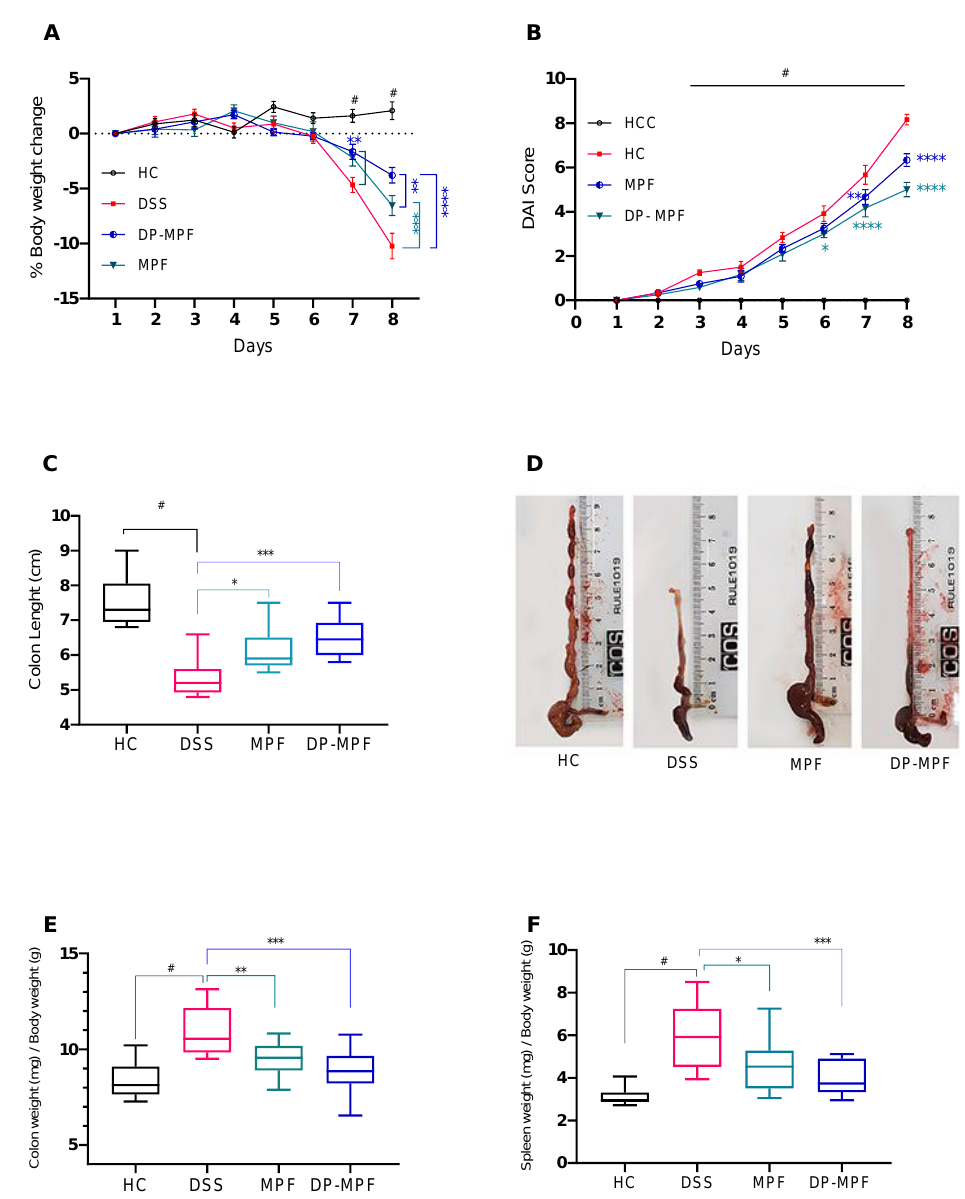
Figure 2. Effect of MPF and DP-MPF on the pathology of dextran sodium sulphate (DSS)-induced acute colitis. ( A ) % body weight change, ( B ) disease activity index (DAI) of healthy controls (HC), DSS, MPF and DP-MPF treated groups. Statistical significance was evaluated using two-way ANOVA followed by Tukey’s post-test. # Significant effect HC vs. DSS ( p < 0.05); * Significant effect treatment vs. DSS (DSS vs. MPF) or (DSS vs. DP-MPF). A p -value of <0.05 was considered significant. * p < 0.05, ** p < 0.001, *** p < 0.0001 and **** p < 0.00001. Data expressed as a mean ± SEM ( n = 12/group). ( C ) Colon length, ( D ) Colon lengths macroscopic appearance, ( E ) Colon weight and ( F ) Spleen weight, as a mean ± SEM ( n = 12/group), assessed using one-way ANOVA followed by Tukey’s post -test.